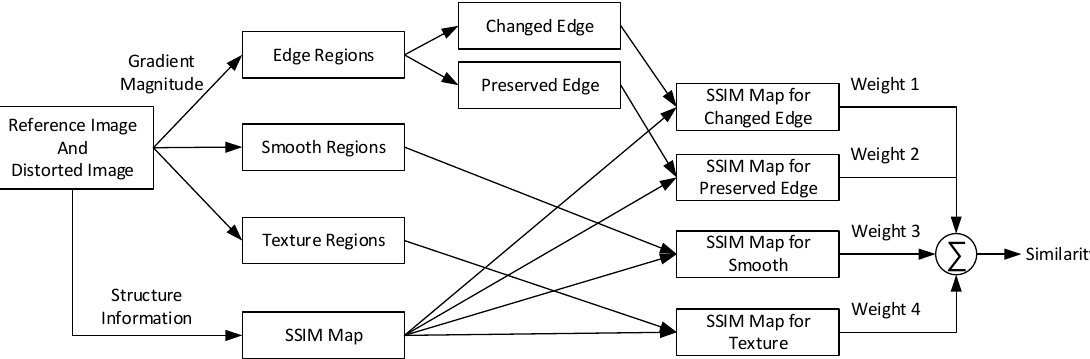
Figure 8. 4-SSIM and its differentiation model procedures to quantify the image quality (adapted from [18]).